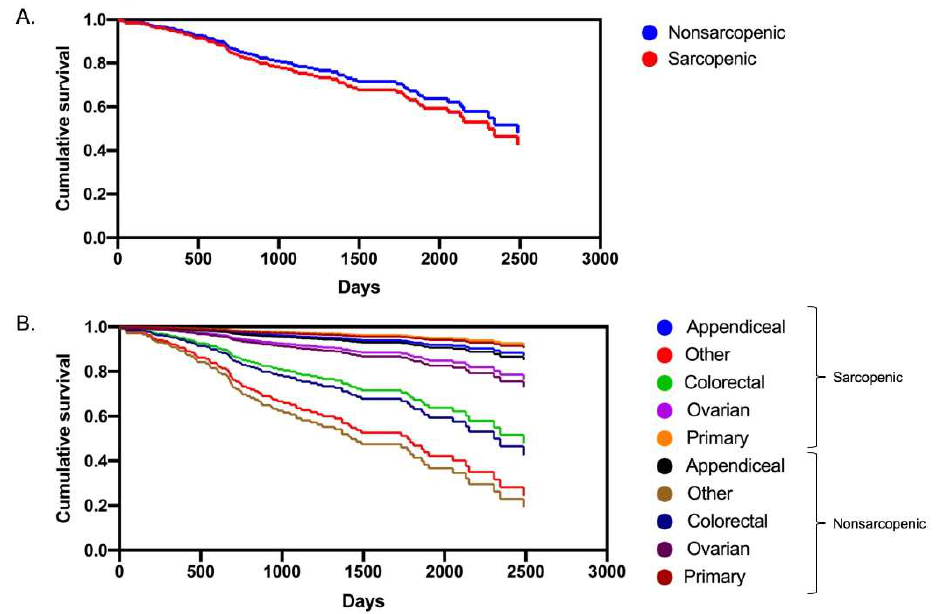
Figure 3. Patient survival according to sarcopenia status in all patients ( A ) and by origin of peritoneal